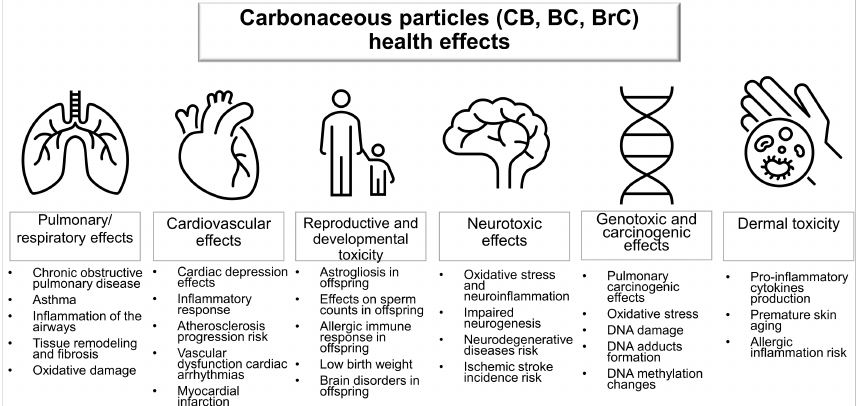
Figure 3. Schematic showing the toxic effects of exposure to CPs in